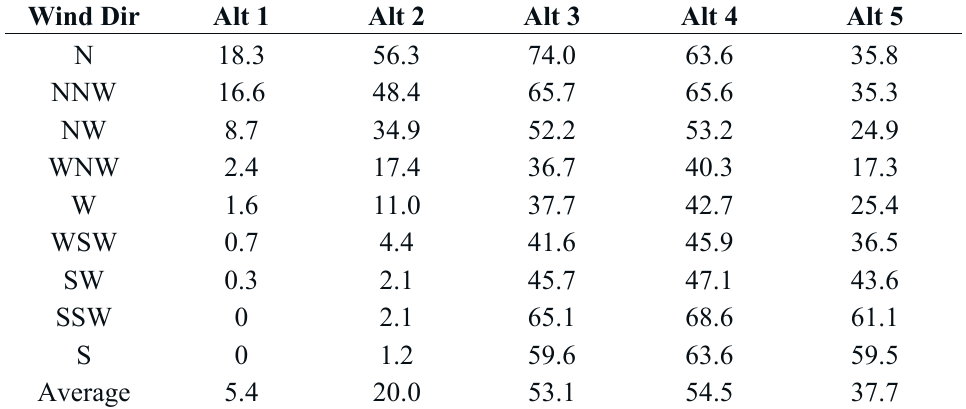
Table 5. Average of wave height reduction factors along south shoreline (Sta 74 to 80) at WL = 0